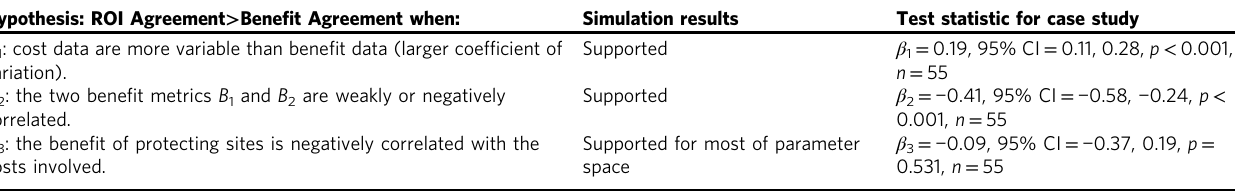
Table 1 Hypotheses regarding when moving to ROI methods will improve agreement levels Hypothesis: ROI Agreement > Bene fi t Agreement when: